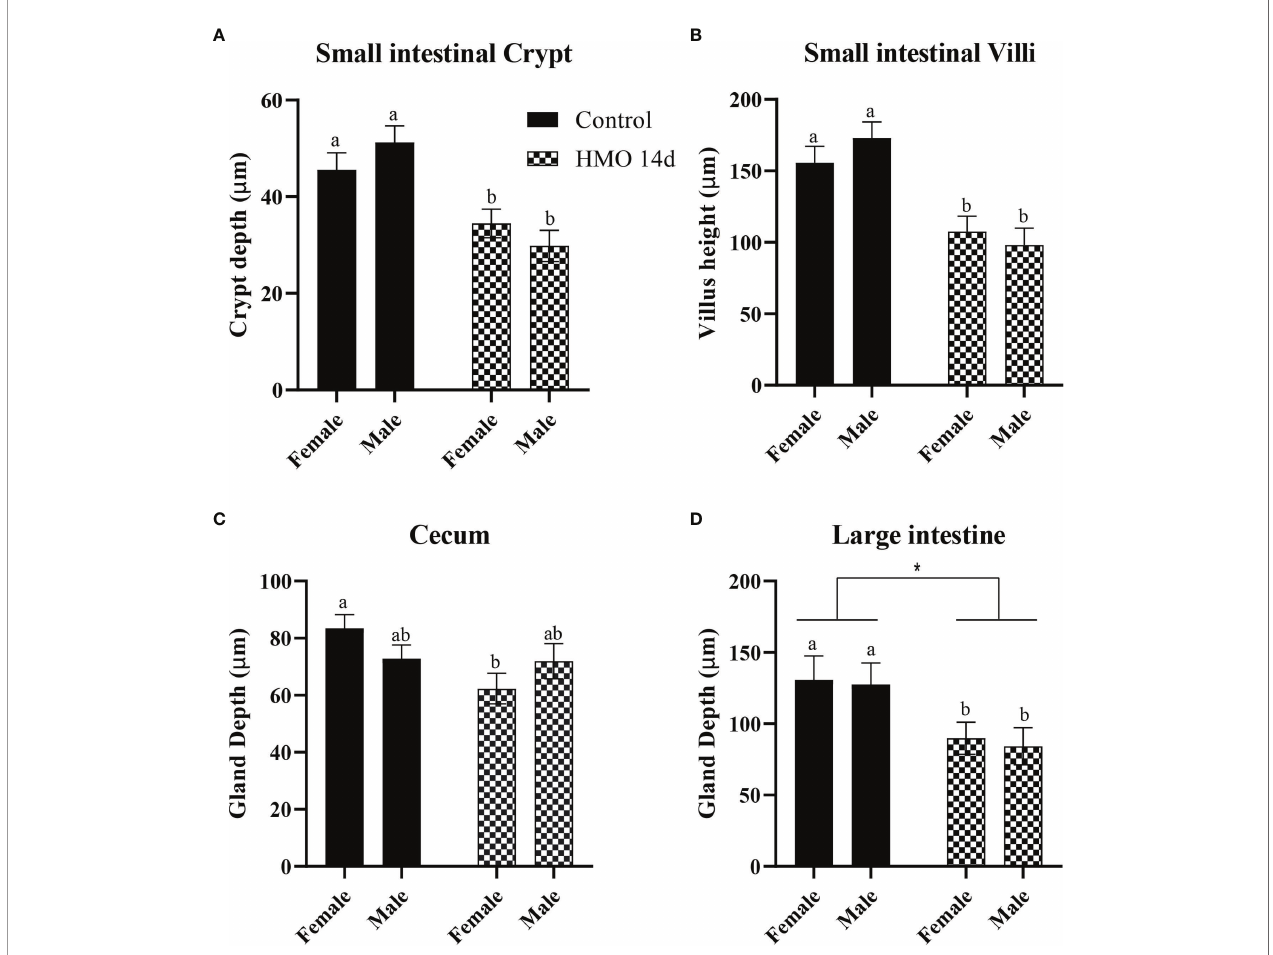
FIGURE 2 | Histomorphometric parameters analyzed in the control groups (n=10; M = 5, F = 5) and in the mice that received HMOs for 14 days and euthanized at 35 days of age (n=7; M = 3, F = 4). (A) SI crypt depth (µm). (B) SI villus height (µm). (C) Cecal gland depth (µm). (D) Large intestinal gland depth (µm). a,b Different superscripts represent the statistical difference between individual groups. *Represents the statistical difference between groups regardless of